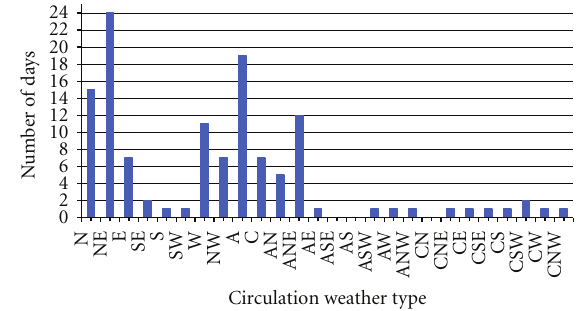
Figure 3: Circulation Weather Type classification in the months of June, July, August, and September